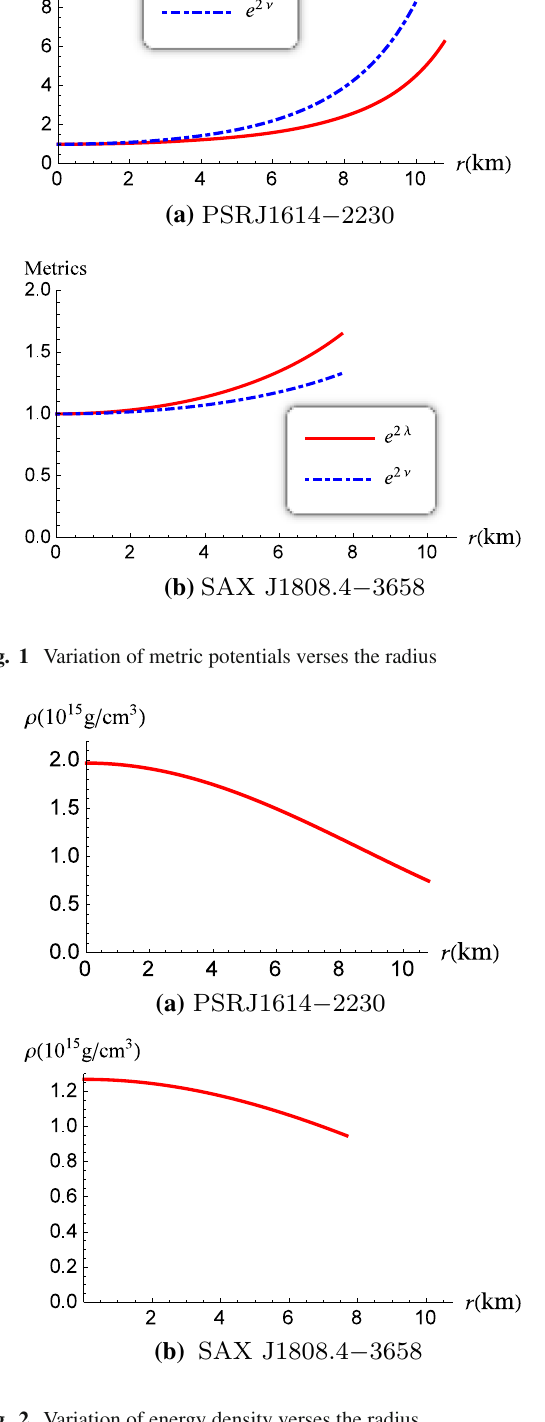
Fig. 4 Variation of anisotropy verses the